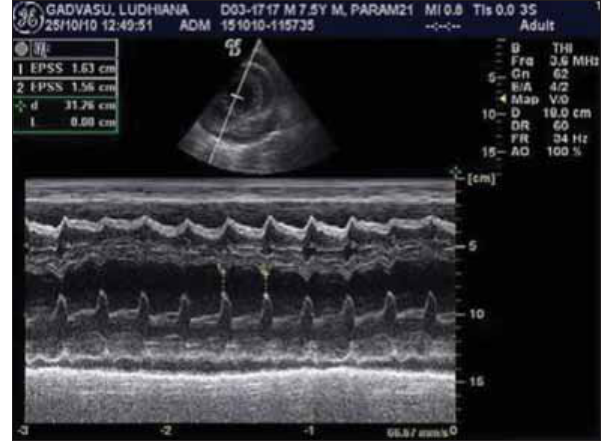
Figure-11: Increased EPSS of animal affected with combined DCM and PE.